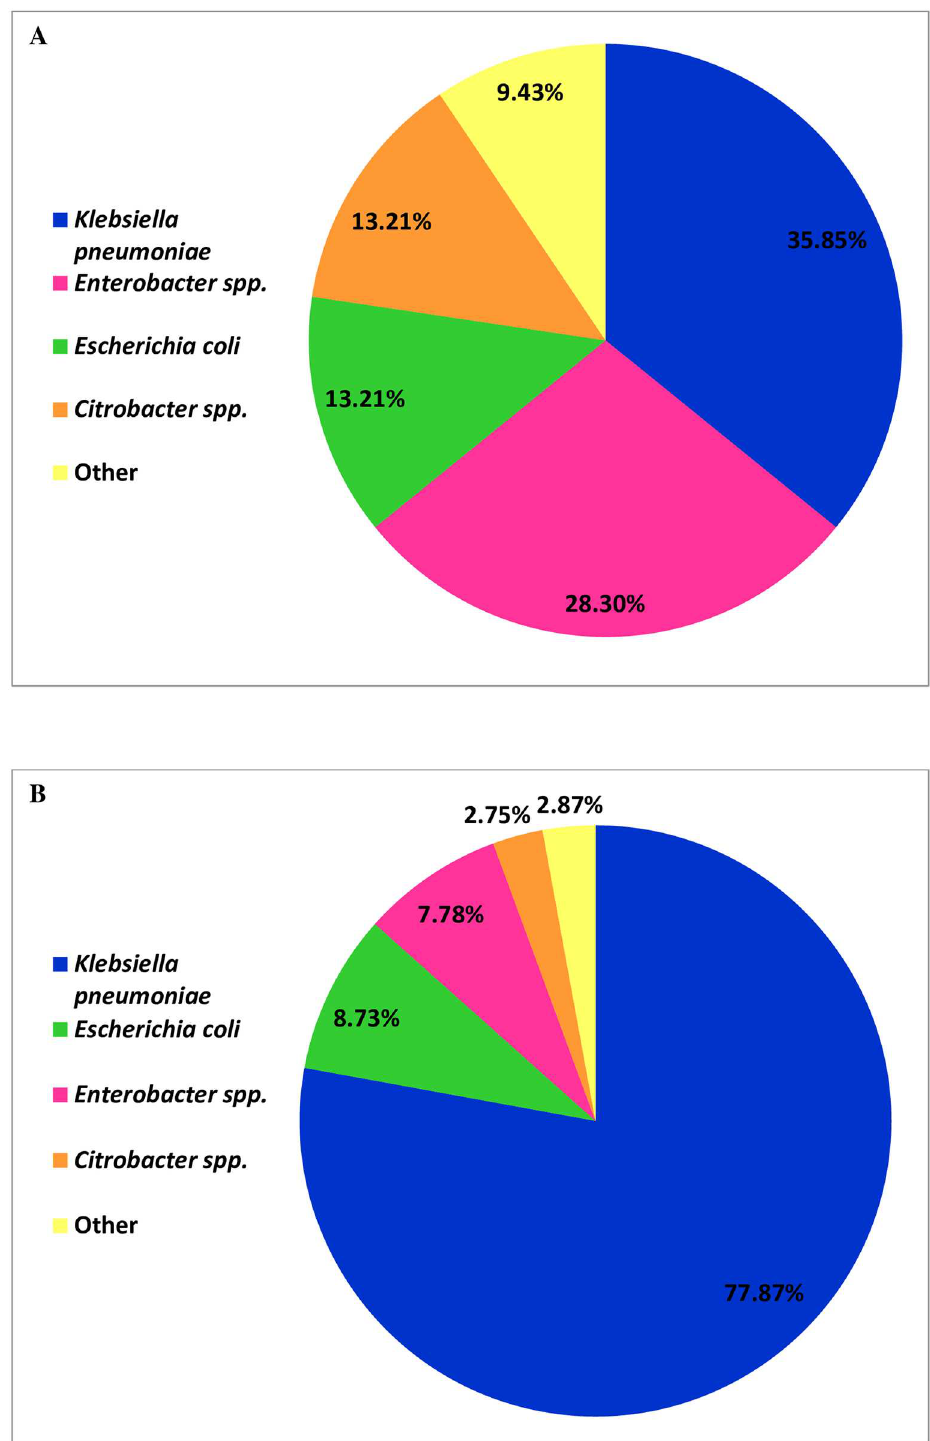
Fig 3. Distribution of bla KPC carrying Enterobacteriacae in sewage compared to clinical isolates. (A) bla KPC carrying Enterobacteriacae found in sewage compared to (B) bla KPC carrying Enterobacteriacae isolates collected in the Microbiology Lab at the Sheba Medical center in 2013. Multiple samples within one patient were